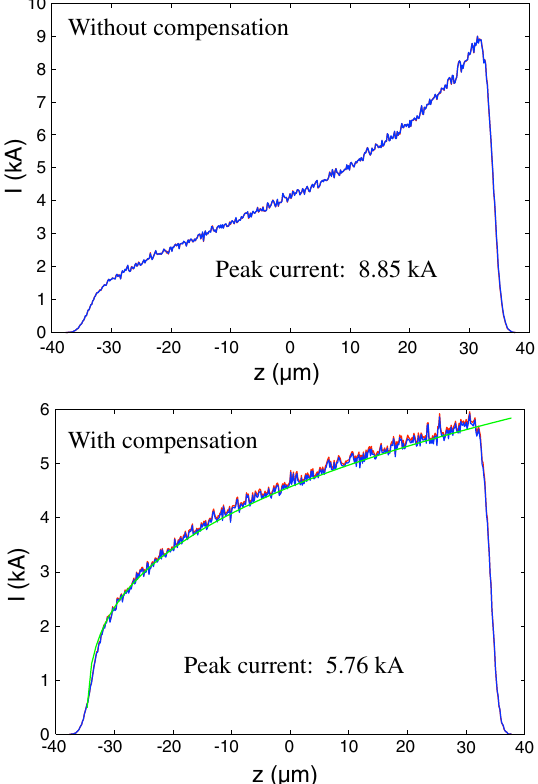
FIG. 9. The current profile at the entry to Bend 4 (blue) is shown both without (upper) and with (lower) compensation for the lattice nonlinear optics, as described in Sec. III B. The lower result is shown together with the compressed optimal current profile (green) of (15), indicating that the initial density profile is